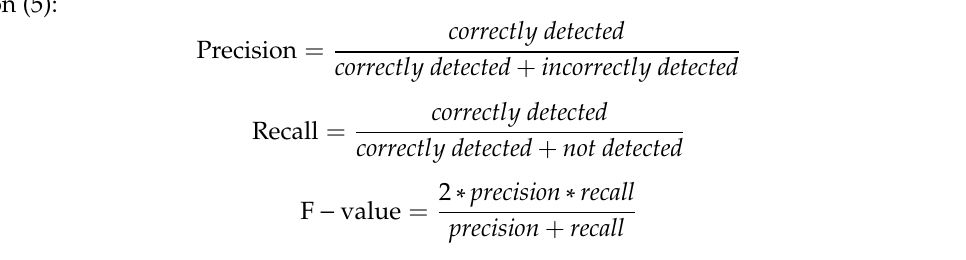
Table 5. Accuracy comparison for detecting road